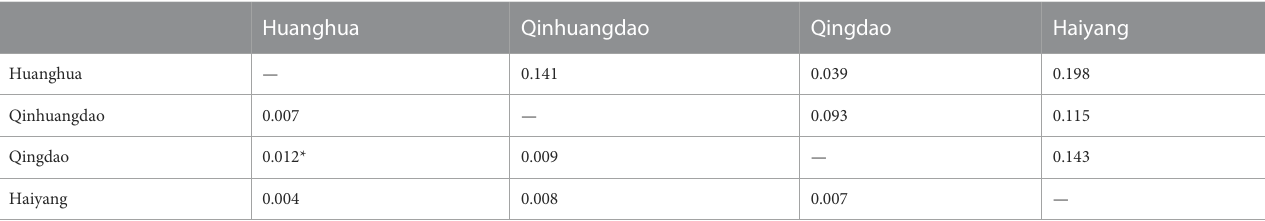
TABLE 4 Fixation index ( F st ) among geographic populations.